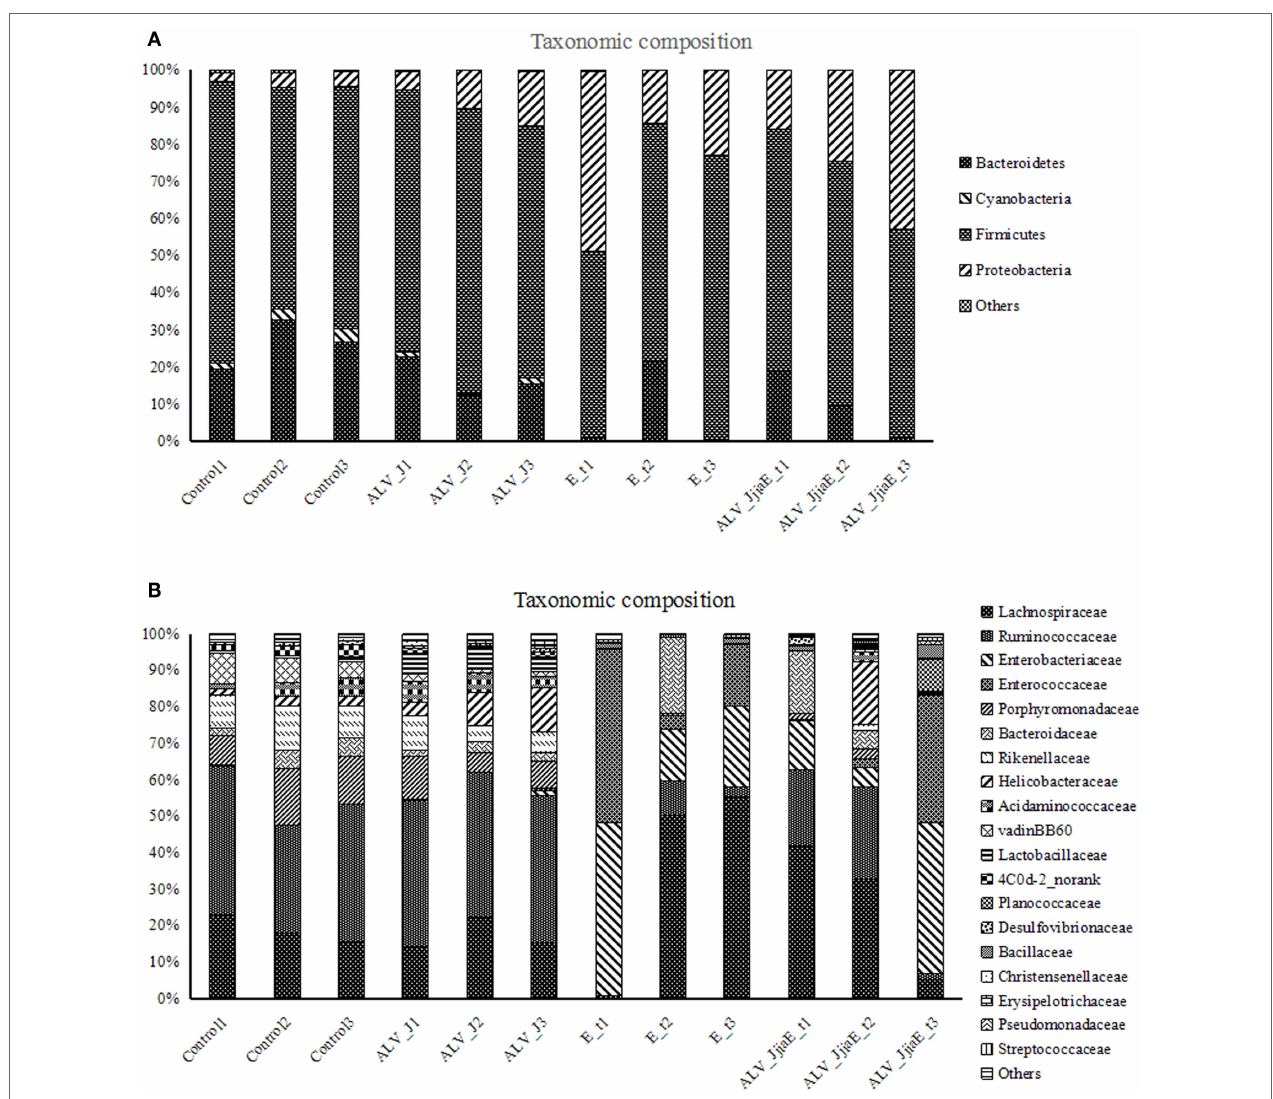
FigUre 3 | Relative contributions of dominant phyla (a) and family (B) in the cecal microbiota using V3–V4 amplicon sequencing ( n =